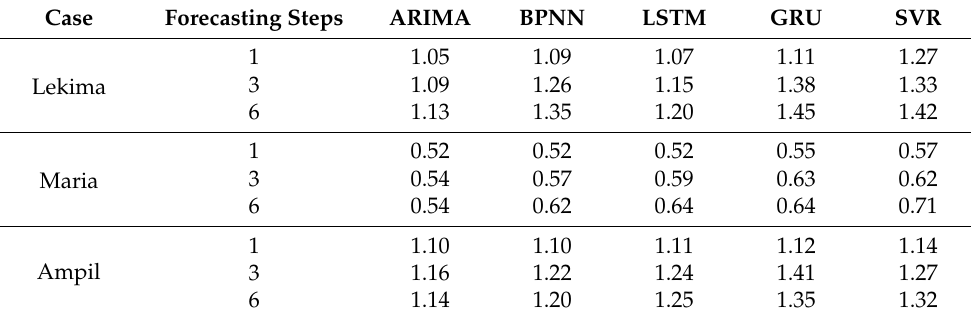
Table 5. MAE of different models in forecasting wind